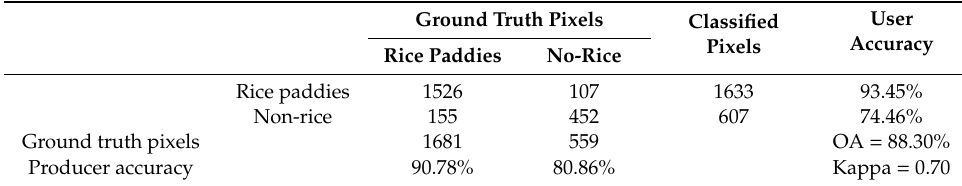
Table 3. Confusion matrix between NLCD-Rice in Nanchang County and validation points from high-resolution images via Google Earth and in-situ